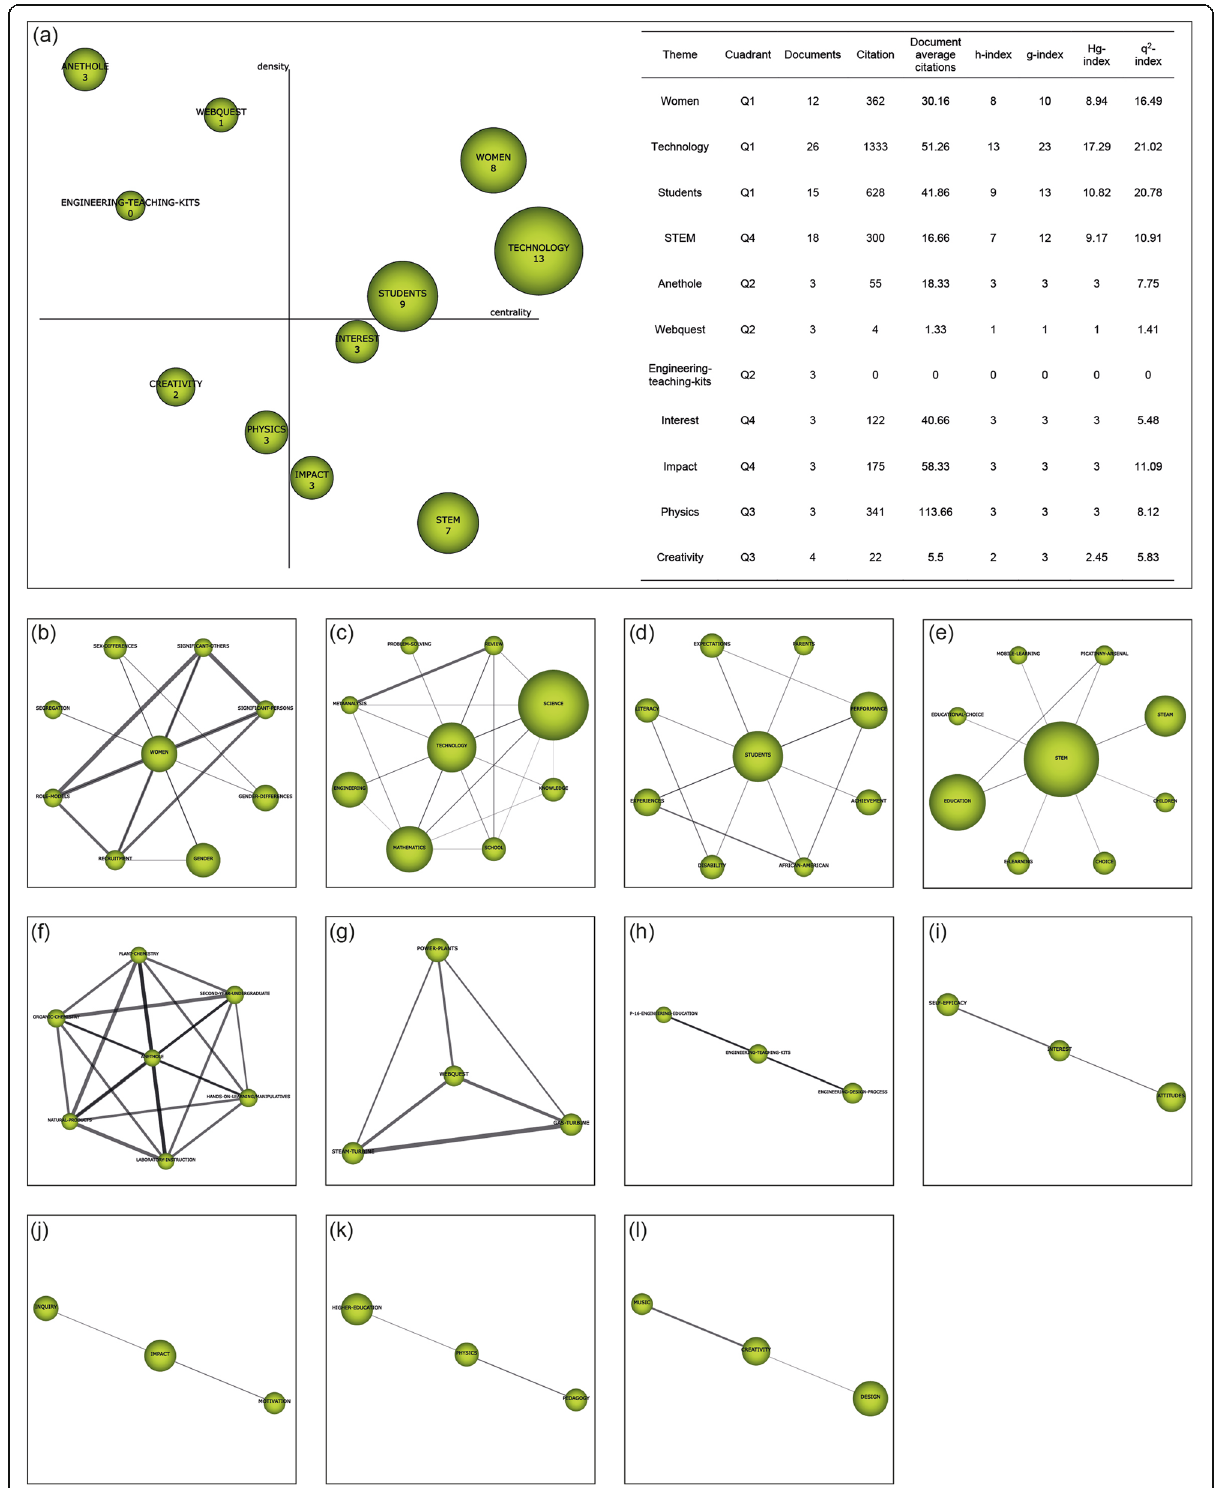
Fig. 5 Strategic diagram of the 2006 to 2015 period. Note . a Strategic diagram (h-index) and performance from 2006 to 2015. Themes include b “ women, ” c “ technology, ” d “ students, ” e “ STEM, ” f “ Anethole, ” g “ webquest, ” h “ engineering-teaching-kits, ” i “ interest, ” j “ impact, ” k “ physics, ” and l “ interest